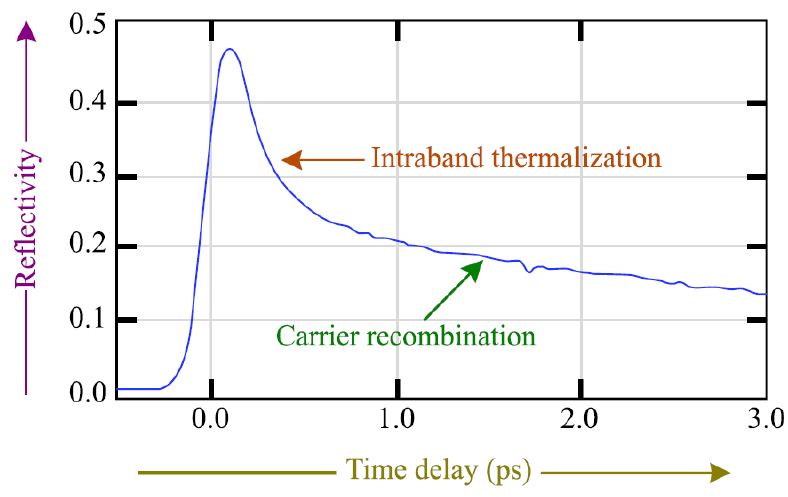
Figure 12. Typical relaxation dynamics of a semiconductor saturable absorber.